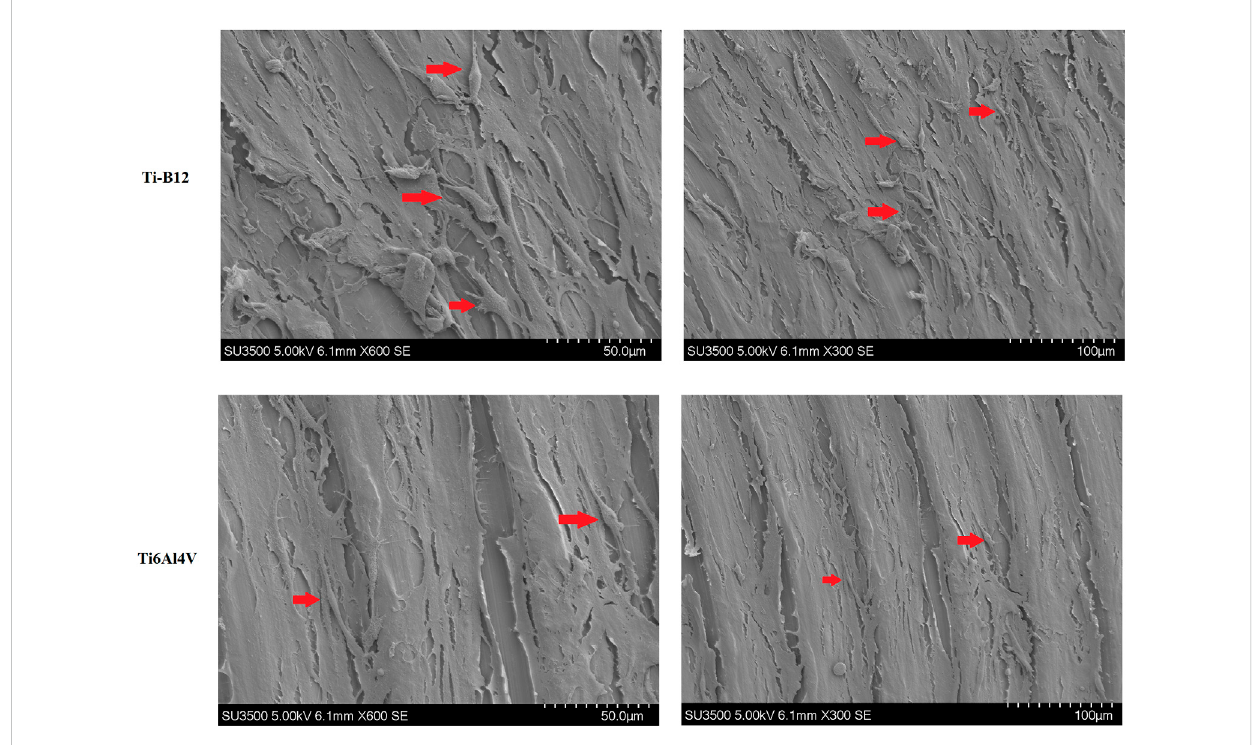
FIGURE 7 Observation by scanning electron microscope of MC3T3-E1 cells on the surface of Ti-B12 and